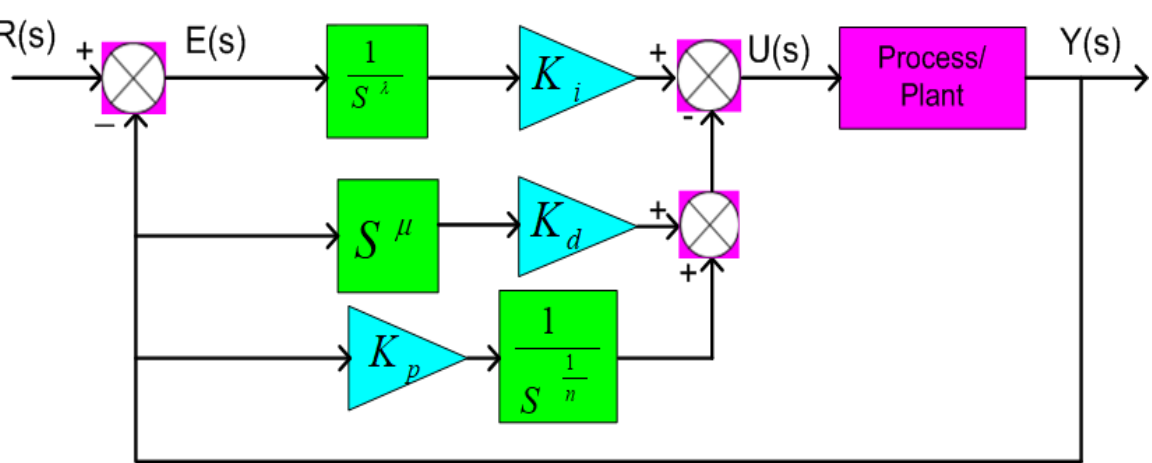
Figure 6. Structure of MFOPID controller.